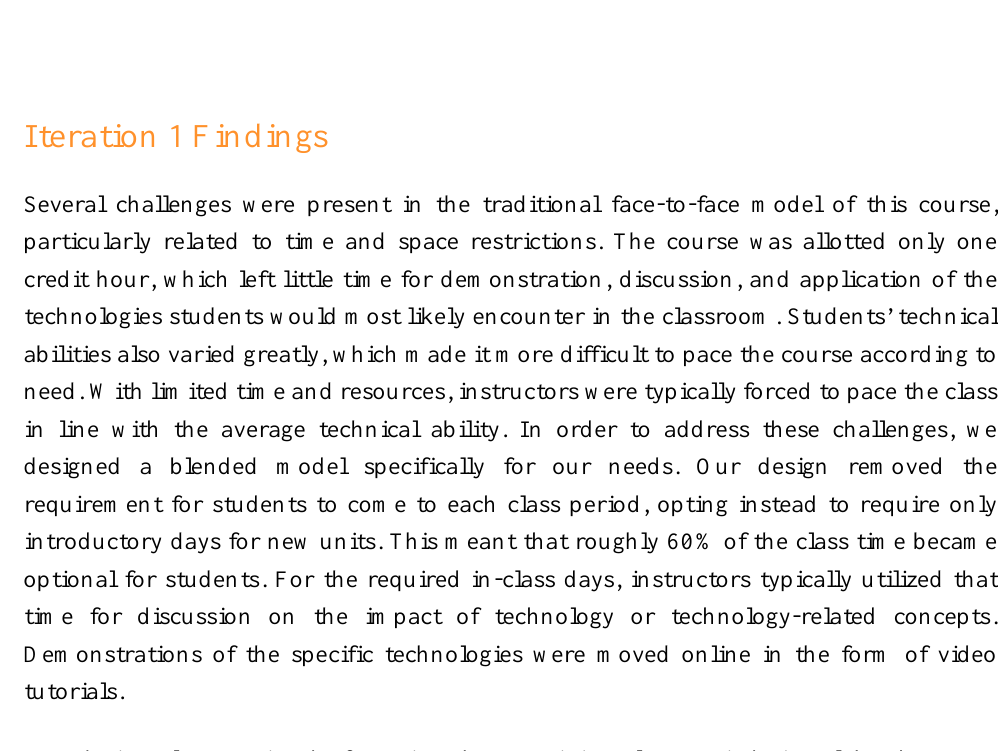
Table 3 Descriptive Statistics for the Baseline Connectedness Score SOC Importance